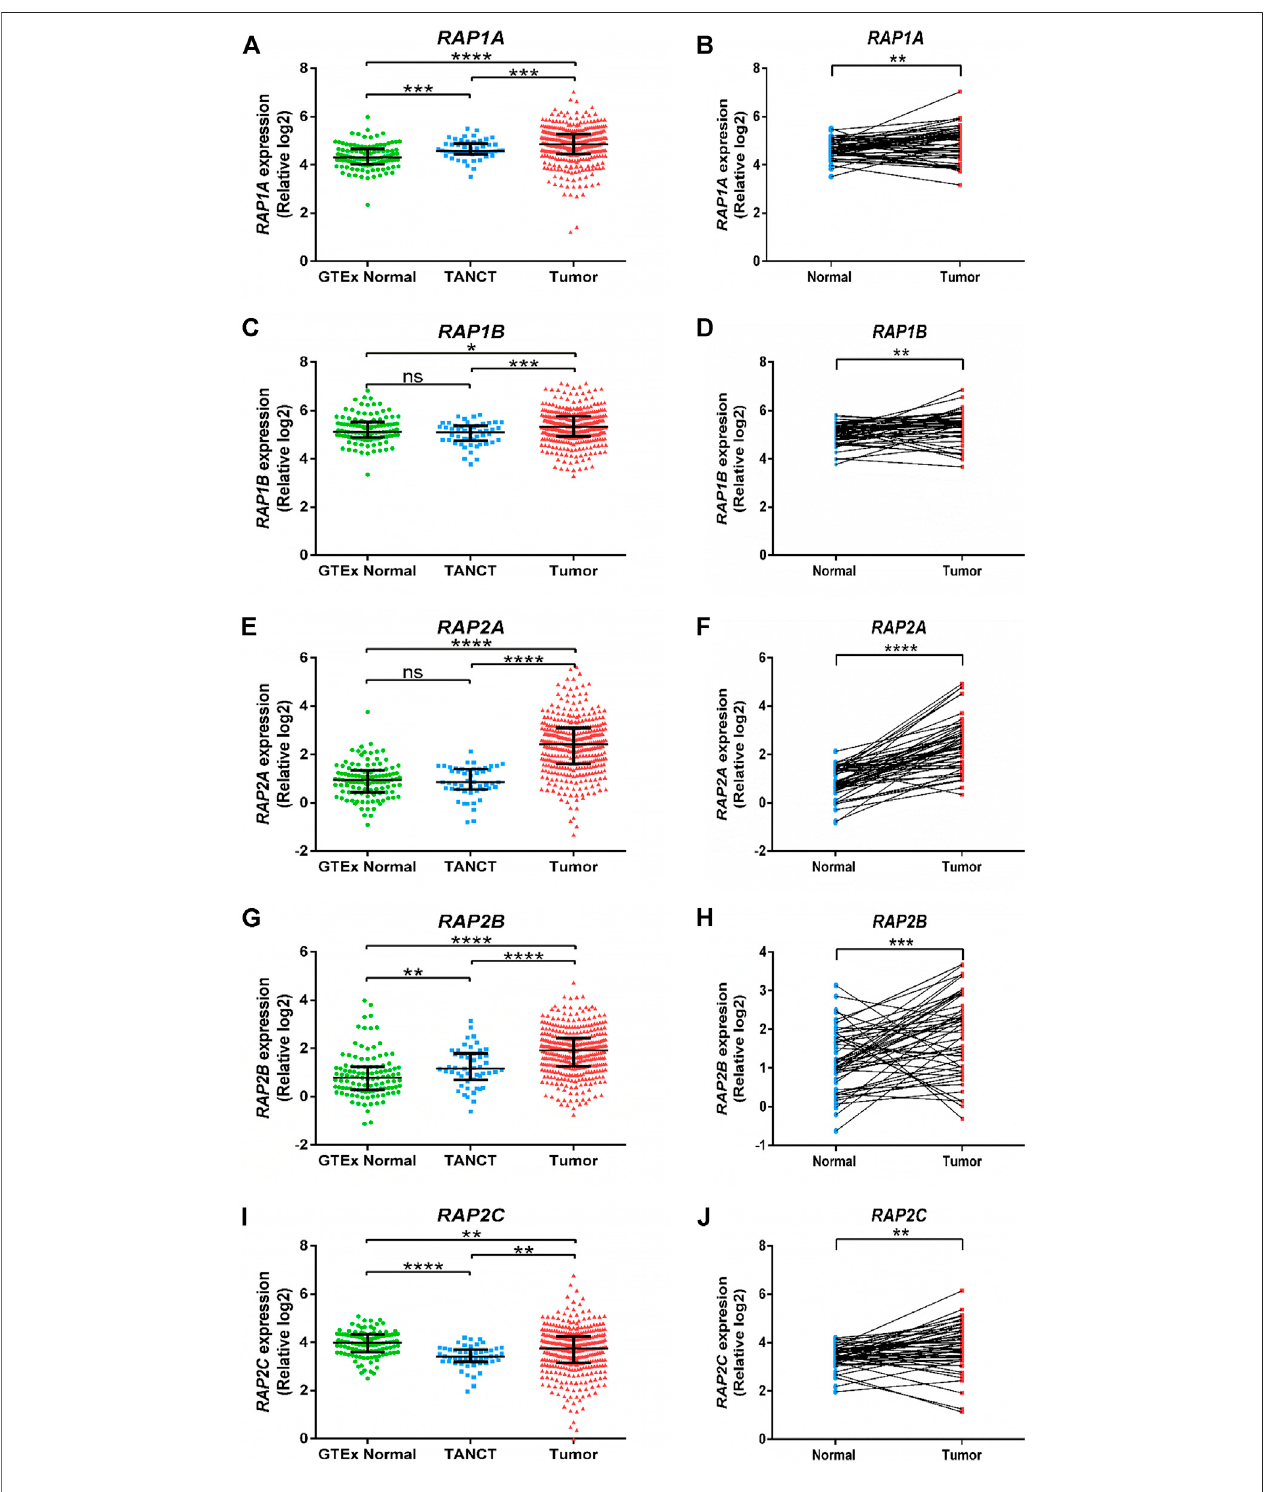
FIGURE 1 | Expression of RAP genes in tumor tissues compared with adjacent normal tissues and normal tissues from GTEx study. GTEx, Genotype-Tissue Expression project; TANCT, tumor adjacent non-cancerous tissue. **** p < 0.0001; *** p < 0.001; ** p < 0.01; * p < 0.05; ns, p > 0.05.